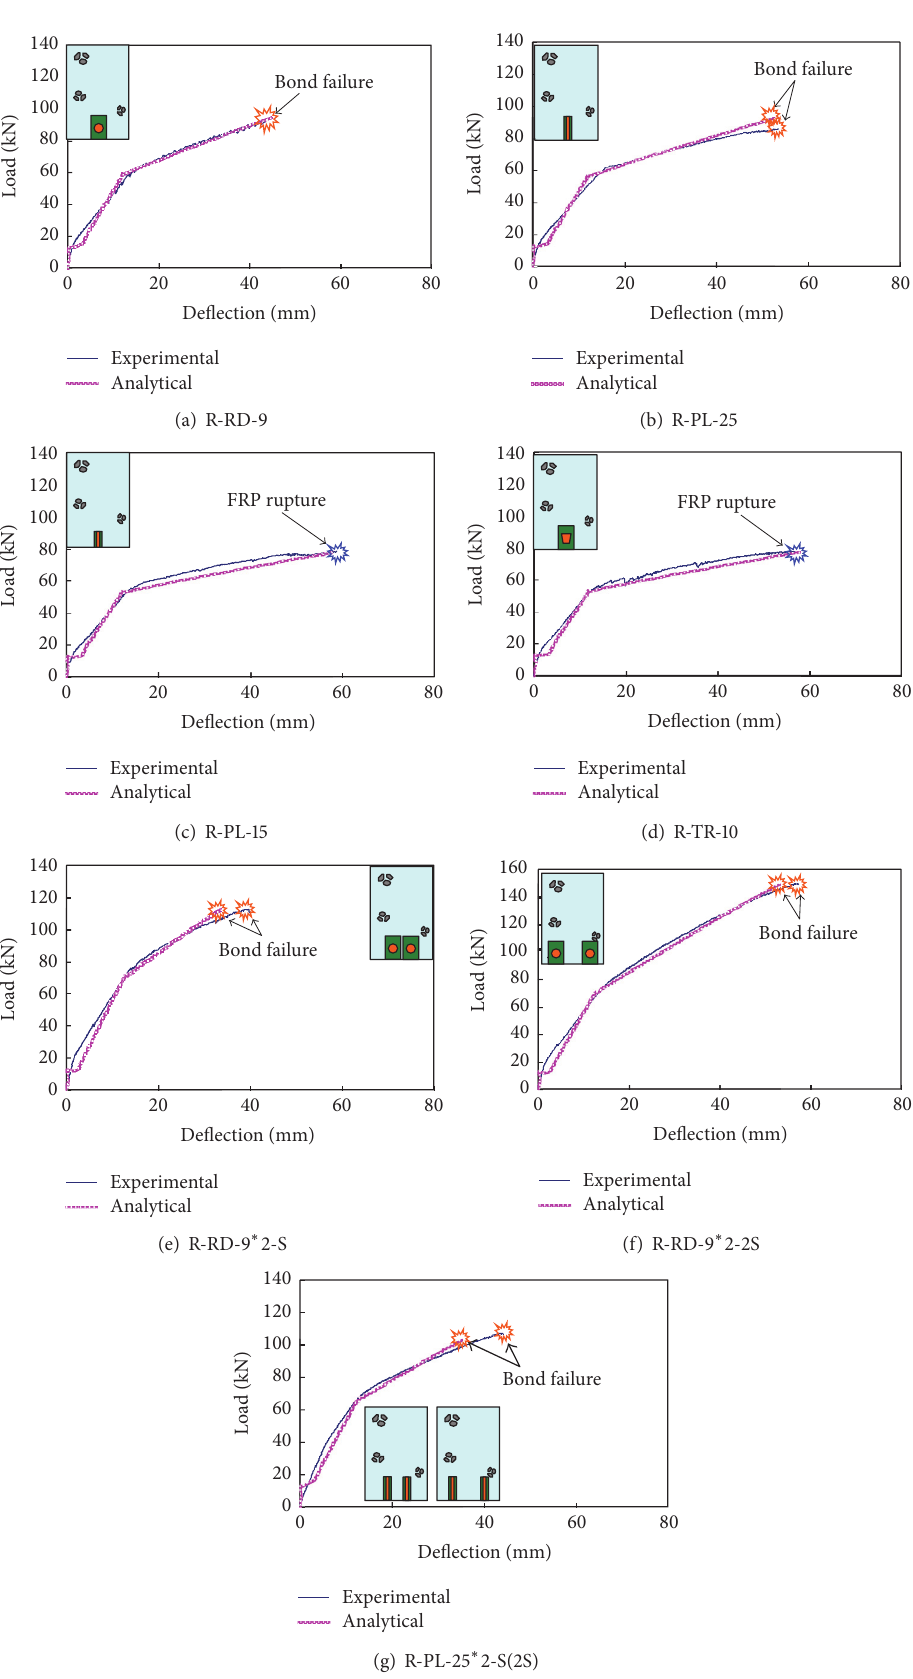
Figure 14: Comparison of experimental and analytical load-deflection